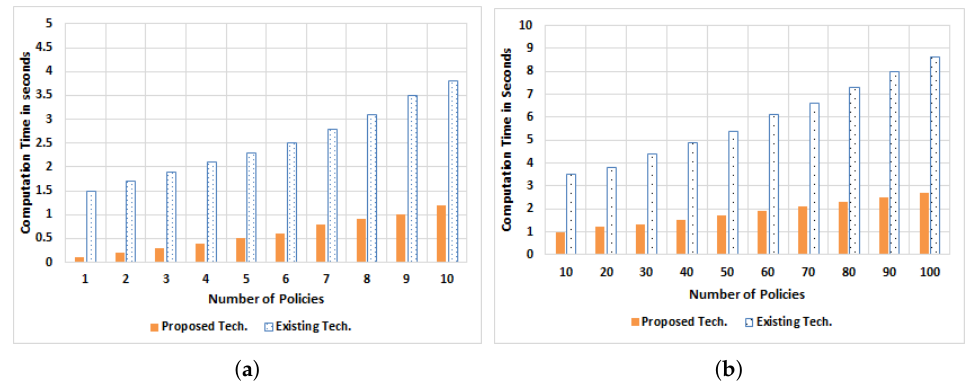
Figure 18. Simulation results of proposed and existing approaches for Graph Computation Time. ( a ) Computation Time when Number of policies is varying, and the number of switches is constant; ( b ) Computation Time when Number of policies is varying and number of switches is